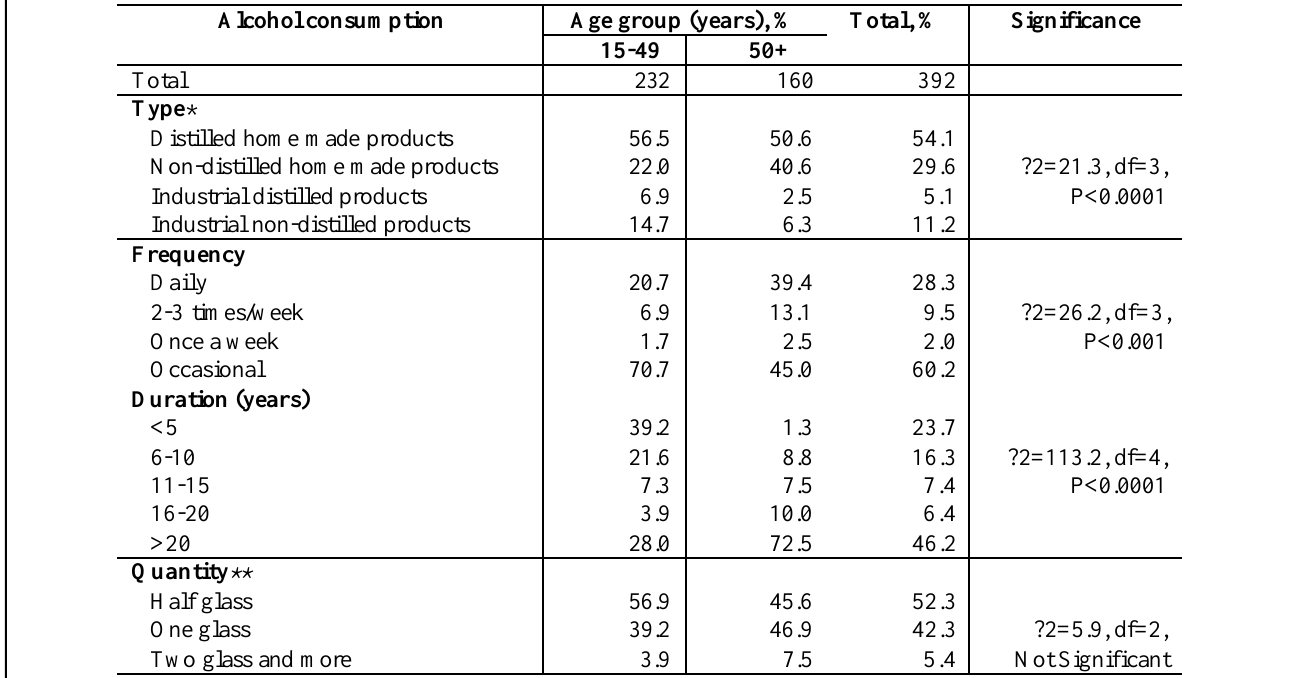
Table II : Pattern of alcohol consumption among the women; Dharan,